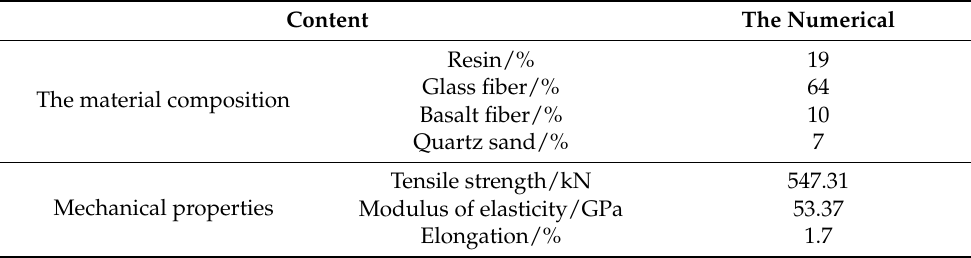
Table 1. Mechanical properties and material composition of the bolt